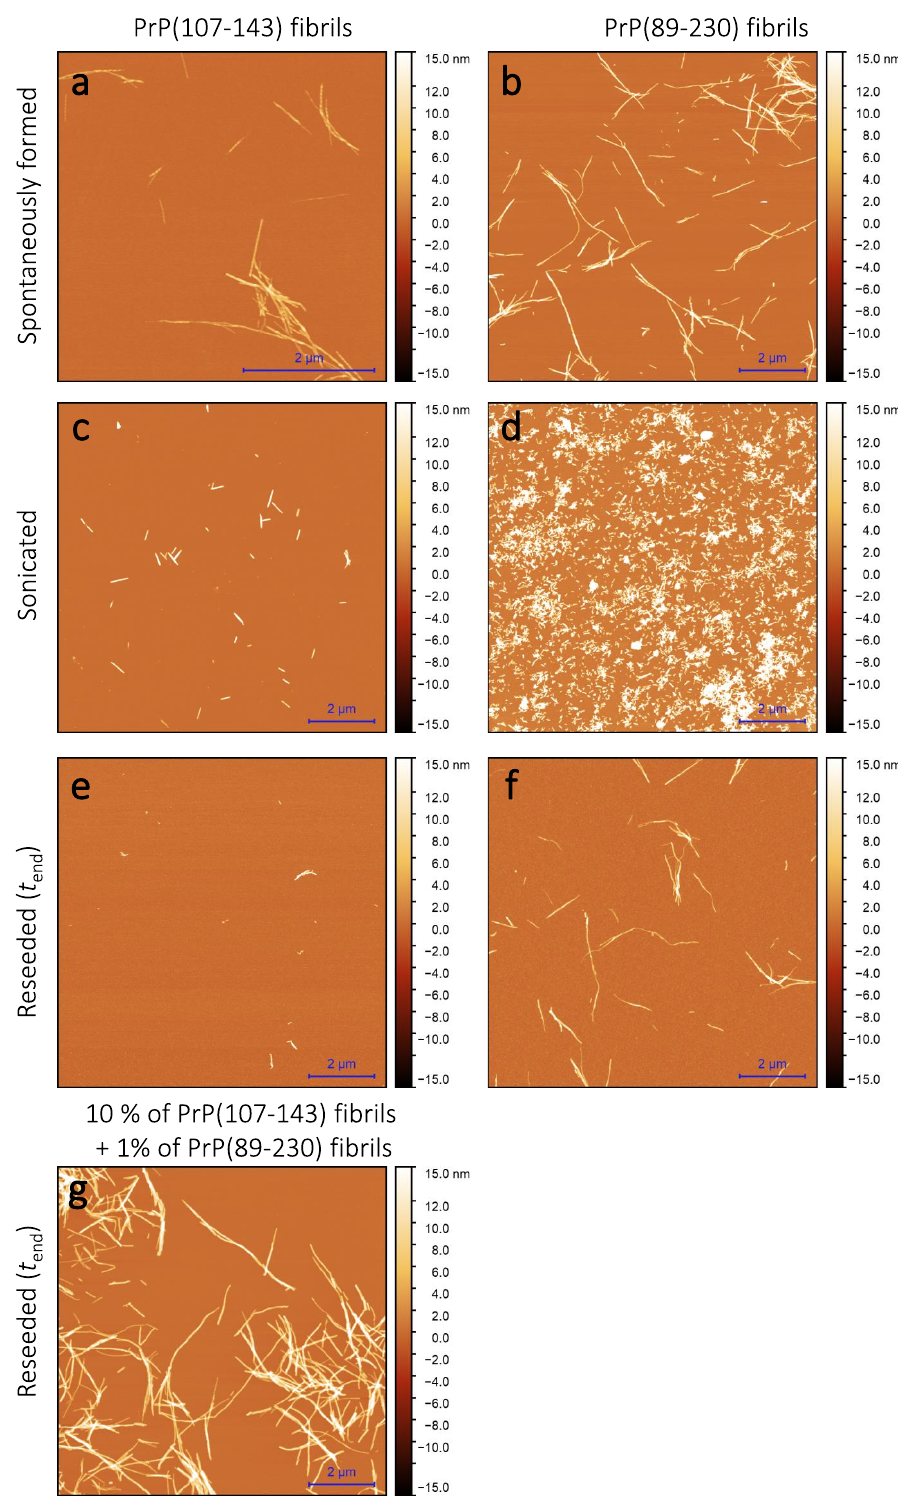
Figure A5. AFM images of PrP(107-143) and PrP(89-230) aggregates. Images of the spontaneously formed PrP(107-143) ( a ) and PrP(89-230) ( b ) aggregates. Images of sonicated PrP(107-143) ( c ) and PrP(89-230) ( d ) aggregates. Images of aggregates formed during PrP(107-143)-fibril-induced ( e ) or PrP(89-230)-seed-induced ( f ) aggregation reaction. Image of aggregates formed in the presence of both PrP(107-143)-fibrils and PrP(89-230)-seed ( g